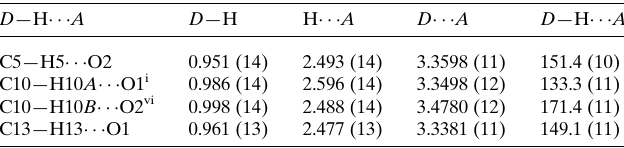
Table 1 Hydrogen-bond geometry (A˚ , (cid:3) ).